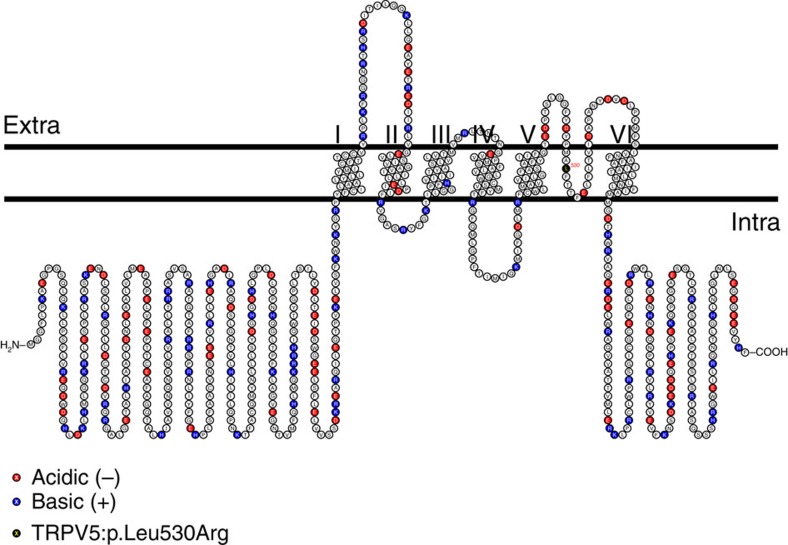
Schematic illustration of the topology of the TRPV5 proteinThe TRPV5 p.L530R mutation occurs within the pore-forming region (amino acids 527–538) of the ion transport domain (amino acids 389–578) of TRPV5 replacing a hydrophobic with a basic amino acid. Acidic and basic amino acids as red and blue, respectively.